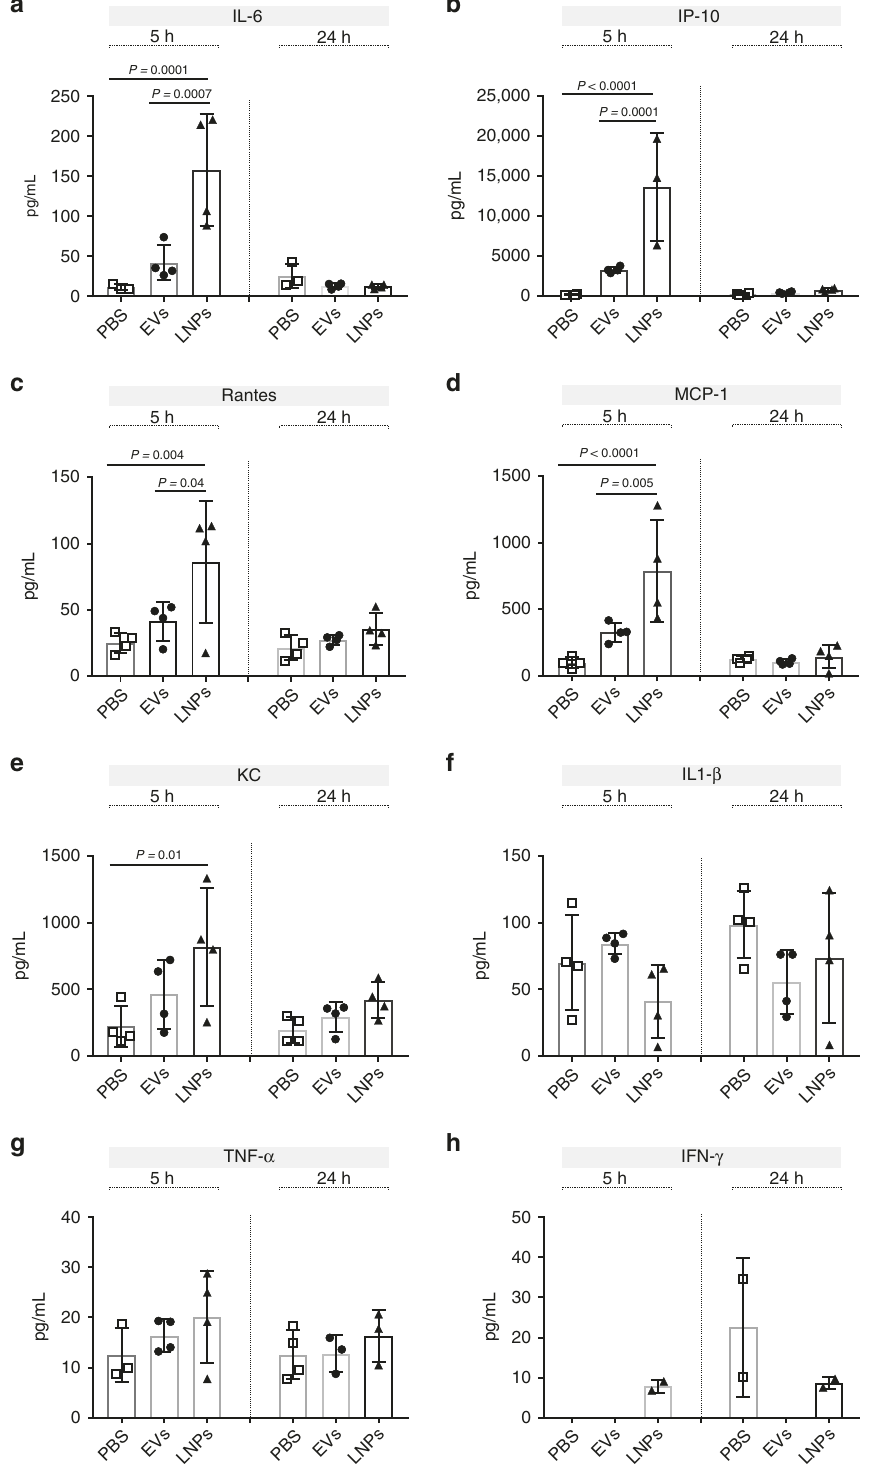
Fig. 6 Cytokine analysis in mouse plasma after mc3-EV and MC3-LNP delivery. Mice were intravenously injected with 100 μ L of mc3-EVs or MC3-LNPs containing 1.5 µ g of hEPO-mRNA (per mouse). The concentrations of eight pro-in fl ammatory cytokines including IL-6 ( a ), IP-10 ( b ), RANTES ( c ), MCP-1 ( d ), KC ( e ), IL1- β ( f ), TNF- α ( g ), and IFN- γ ( h ) were determined in mouse plasma after 5 and 24 h of mc3-EV, MC3-LNP or PBS injection. The levels of pro- in fl ammatory cytokines were signi fi cantly higher in mice receiving LNP injection than in those receiving EV injection. White squares: PBS, black circles: EVs and black triangles: LNPs. Data are presented as the mean (bars) and standard deviation (SD) n = 4 independent animals at each time point. Statistical analysis was performed using one-way ANOVA, followed by Sidak ’ s multiple comparisons test. Signi fi cant differences are shown as p-values. Source data are provided as a Source Data fi